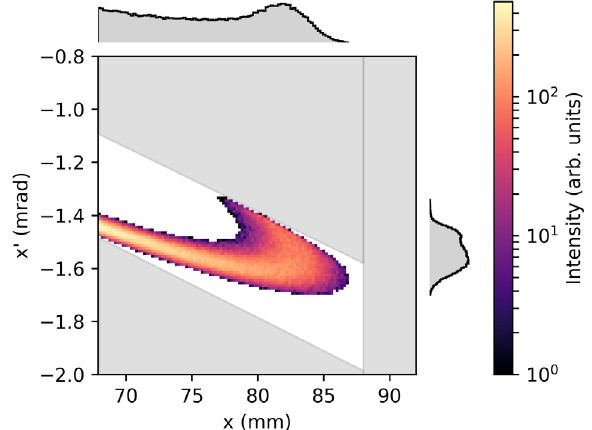
FIG. 20. Extracted beam in phase space on the high-field side upstream of the ZS simulated fitted to the measured beam profile distribution with the multipoles powered ( k 2 ¼ 2 . 1 k 2 k 3 L ¼ − 2 . 45 m − 3 . The acceptance limit of the LSS2 extraction channel is shaded